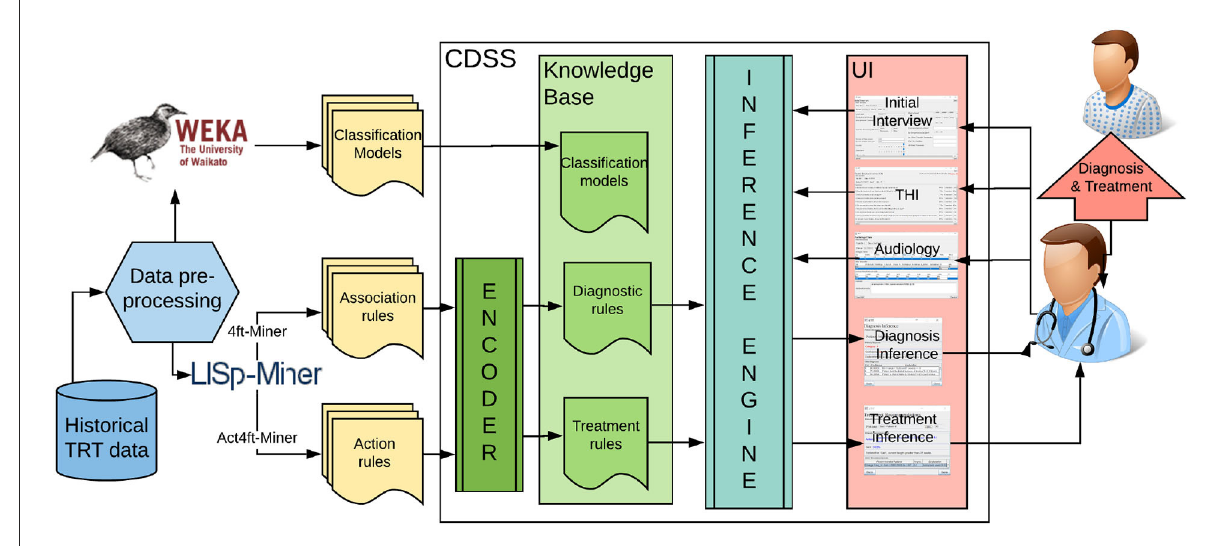
FIGURE1 The architecture of the proposed data-driven clinical decision support system for tinnitus diagnosis and